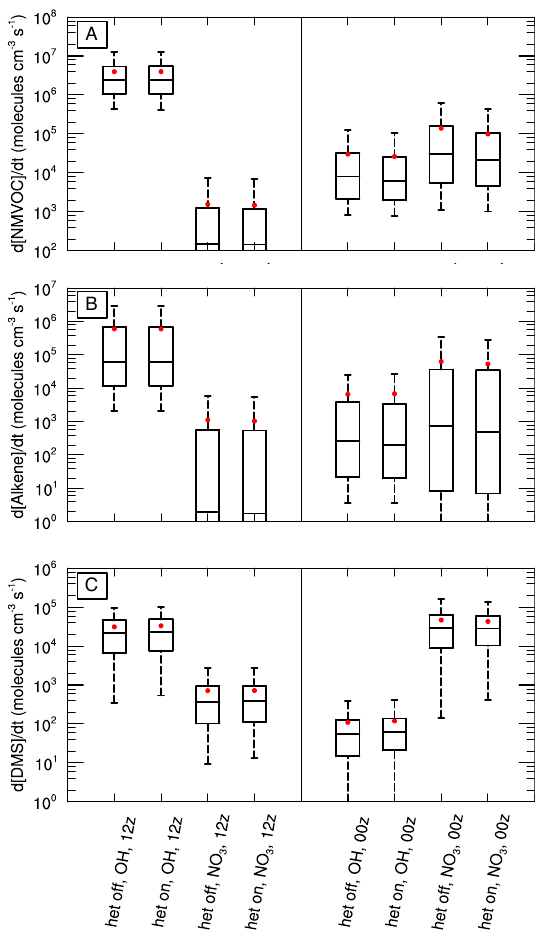
Figure 15. Statistical analysis of variation in oxidation rates, across the domain on the 990hPa pressure level, for total NMVOCs, alkenes, and DMS ( a–c , respectively). Data are presented for ox- idation with respect to OH and NO 3 , at midday (12:00UTC) and midnight (00:00UTC), and for both the “het off” and “het on” sce- narios, as indicated by the x axis labels. Hourly data from a 15- day period are used to obtain a campaign-averaged diurnal cycle. Whiskers indicate the 5th and 95th percentiles, while the red mark- ers indicate the mean oxidation